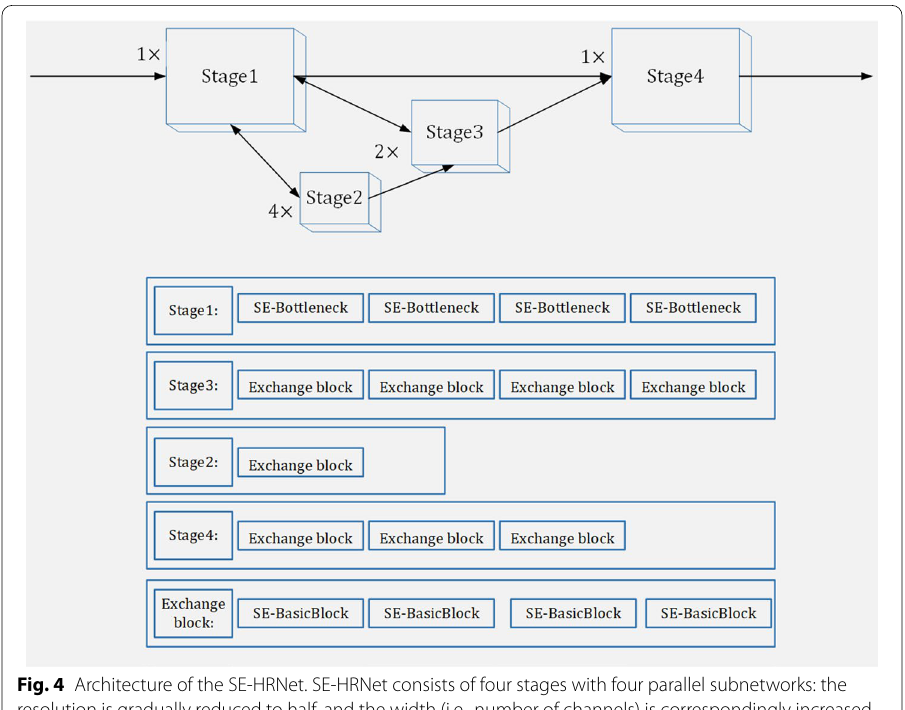
Fig. 4 Architecture of the SE-HRNet. SE-HRNet consists of four stages with four parallel subnetworks: the resolution is gradually reduced to half, and the width (i.e., number of channels) is correspondingly increased twice